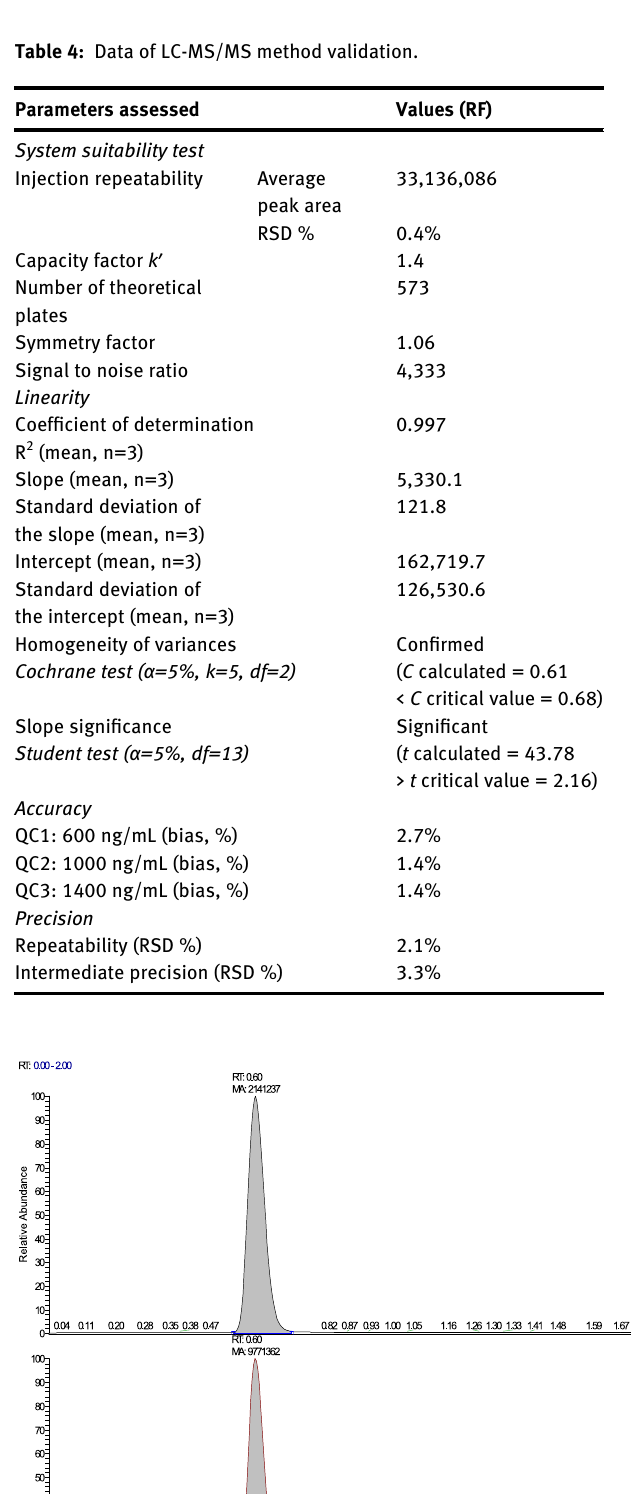
Figure 4: Representative LC-MS/MS chro- matograms of midazolam hydrochloride solution at 1,000 ng/mL (as free base): transition of con fi rmation ( m / z 326 → 249) and transition of quanti fi cation ( m / z 326 → 291).